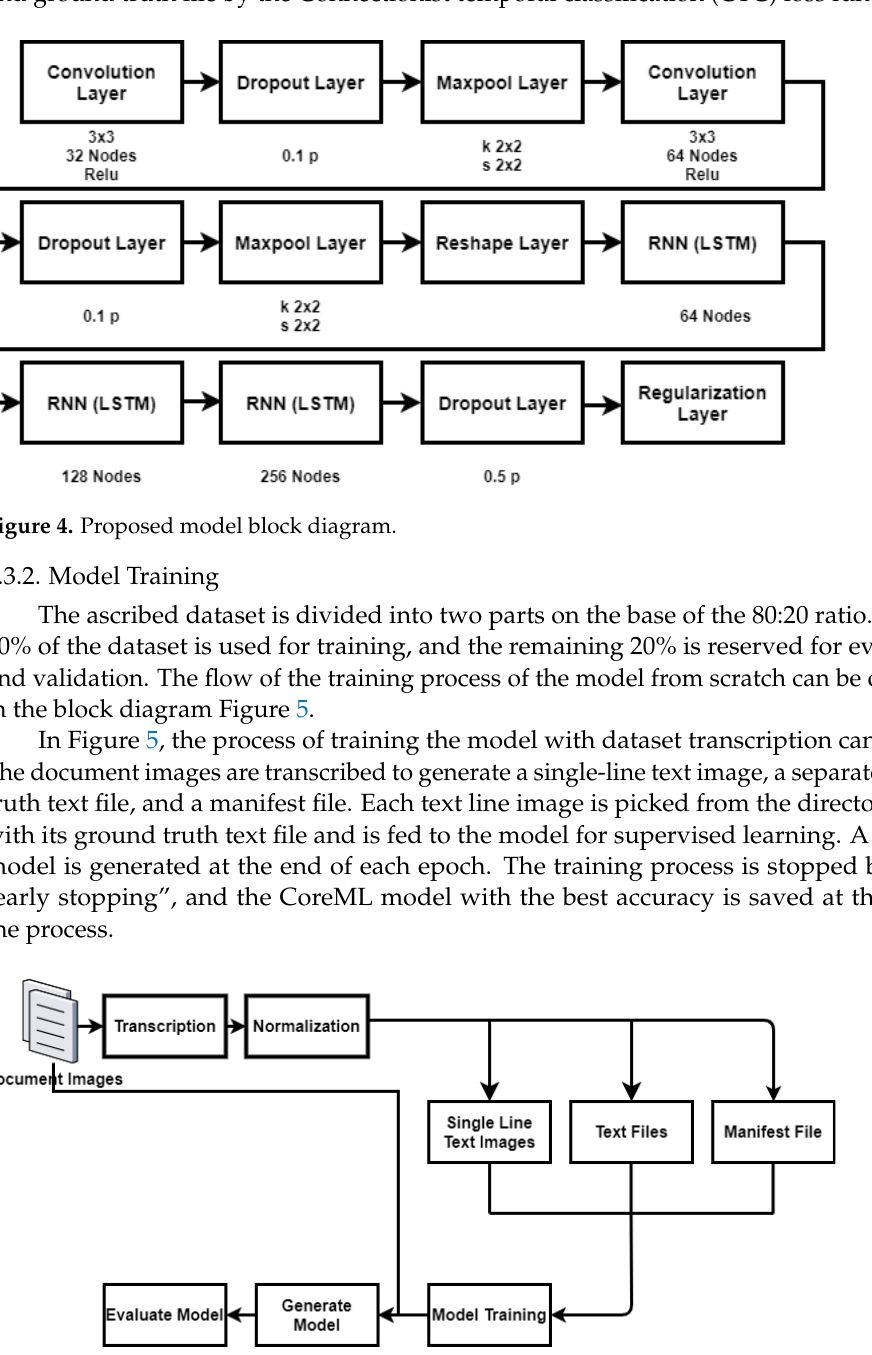
Figure 5. Model training block